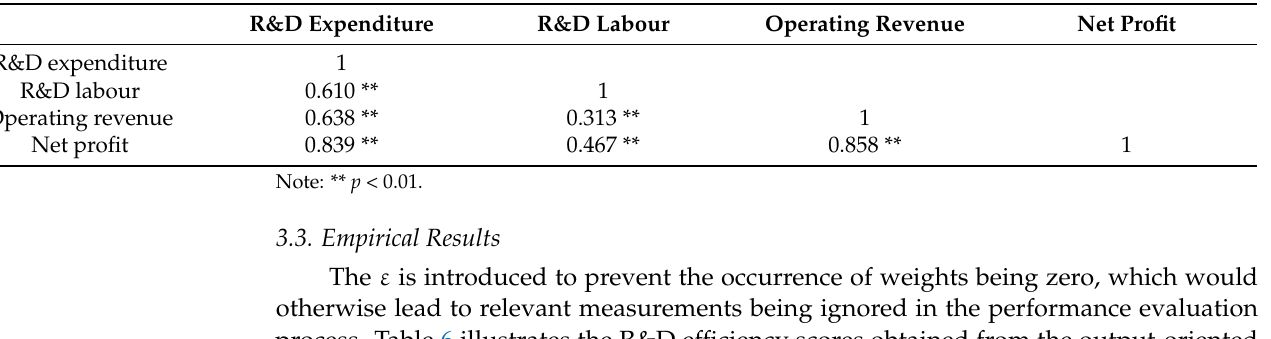
Table 5. Coefficient of correlation between inputs and outputs.